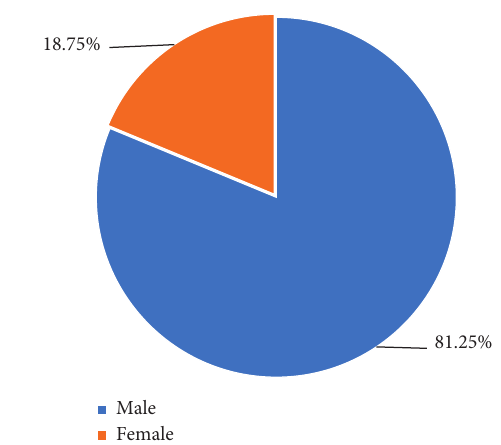
Figure 2: User gender-scale sector diagram.